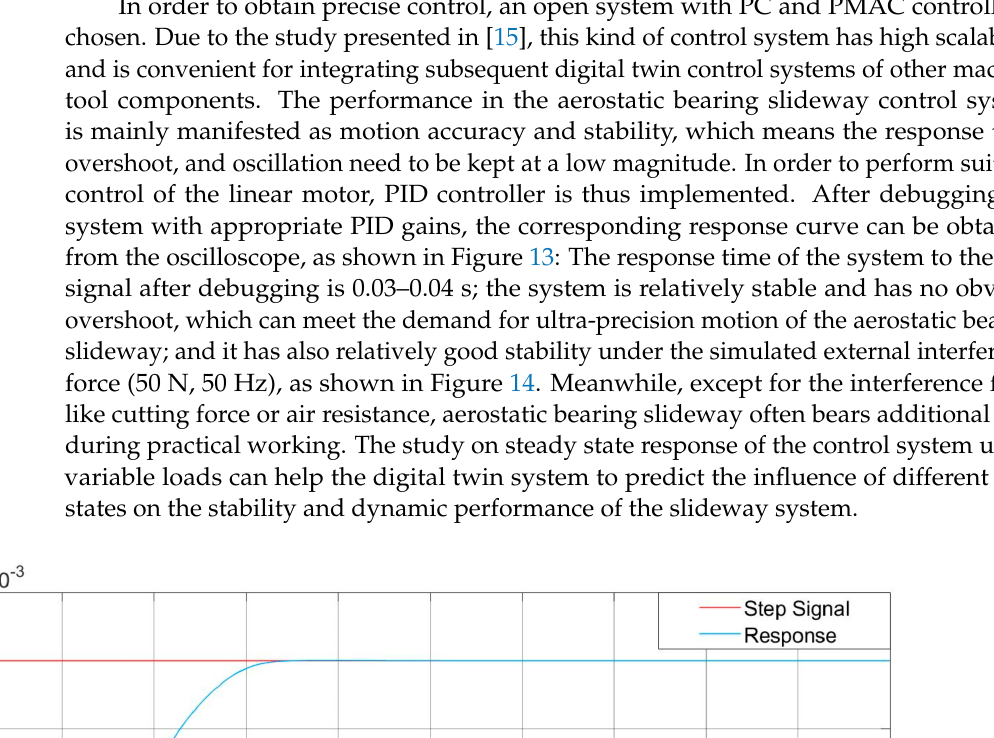
Figure 12. SIMULINK system model and subsystem details.